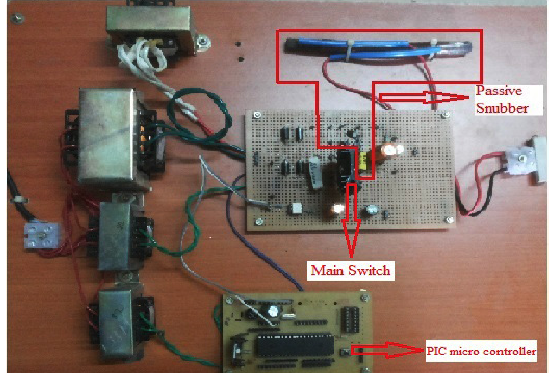
Figure 5. Prototype model.